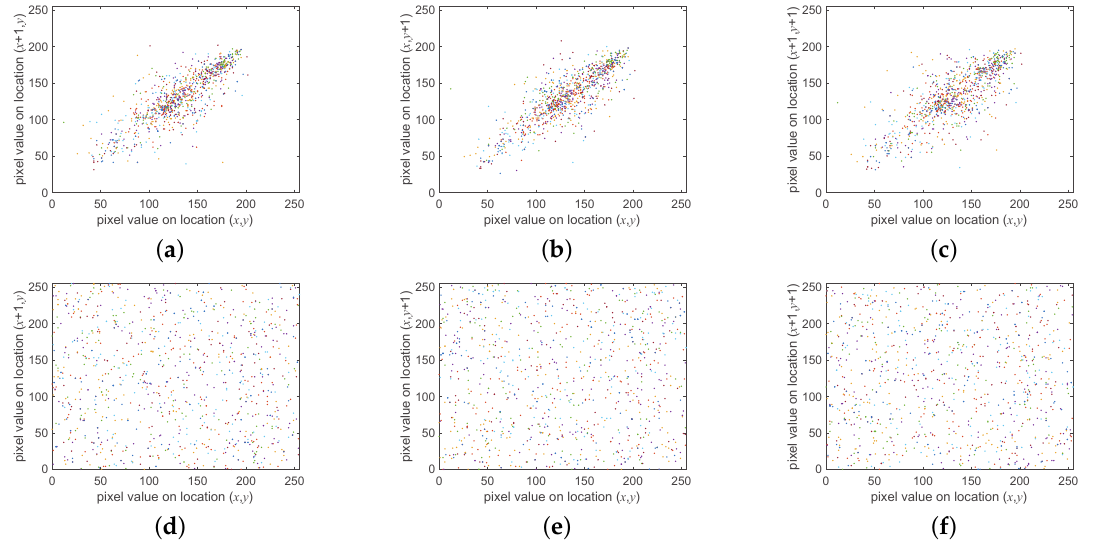
Figure 8. Correlation of adjacent pixel pairs for the baboon image. ( a ) Plain image by horizontal direction; ( b ) plain image by vertical direction; ( c ) plain image by diagonal direction; ( d ) cipher image by horizontal direction; ( e ) cipher image by vertical direction; ( f ) cipher image by diagonal direction. Table 1. Correlation coefficients of adjacent pixel pairs in sample images for the proposed